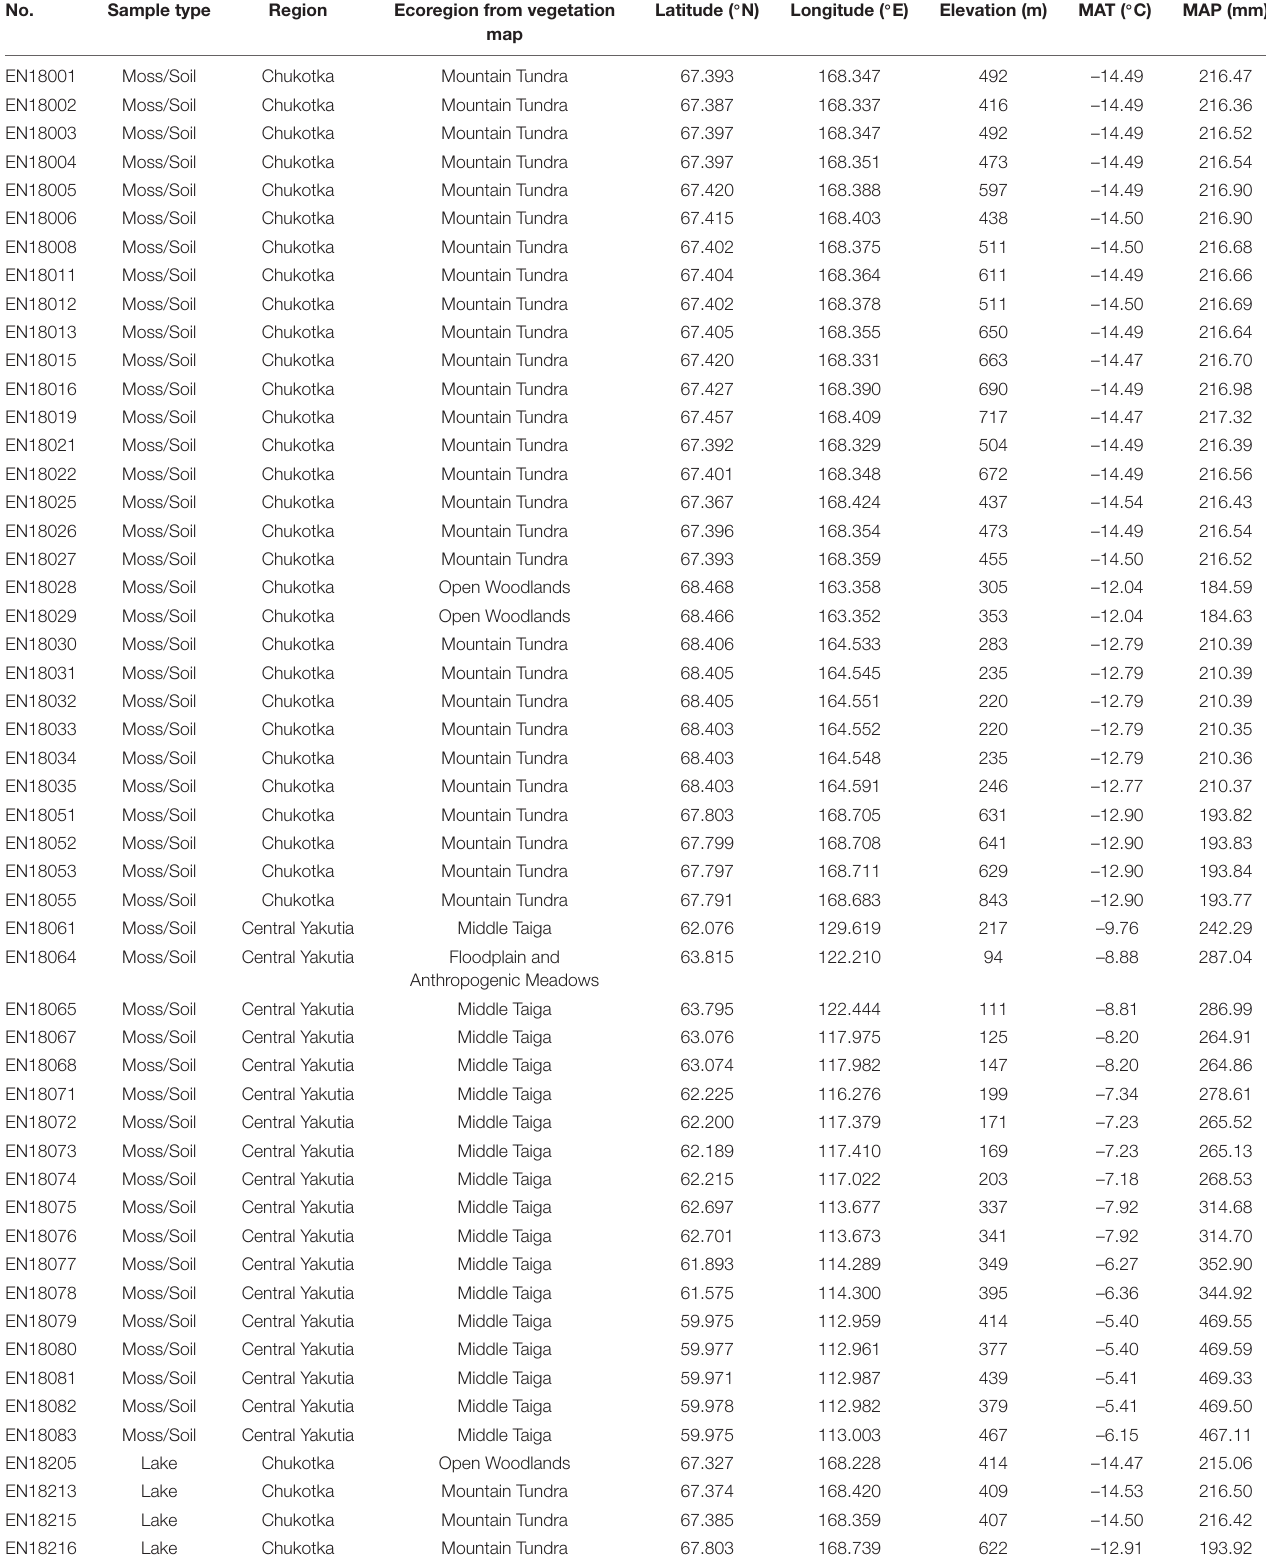
TABLE 1 | Information about the 72 sampling sites in East